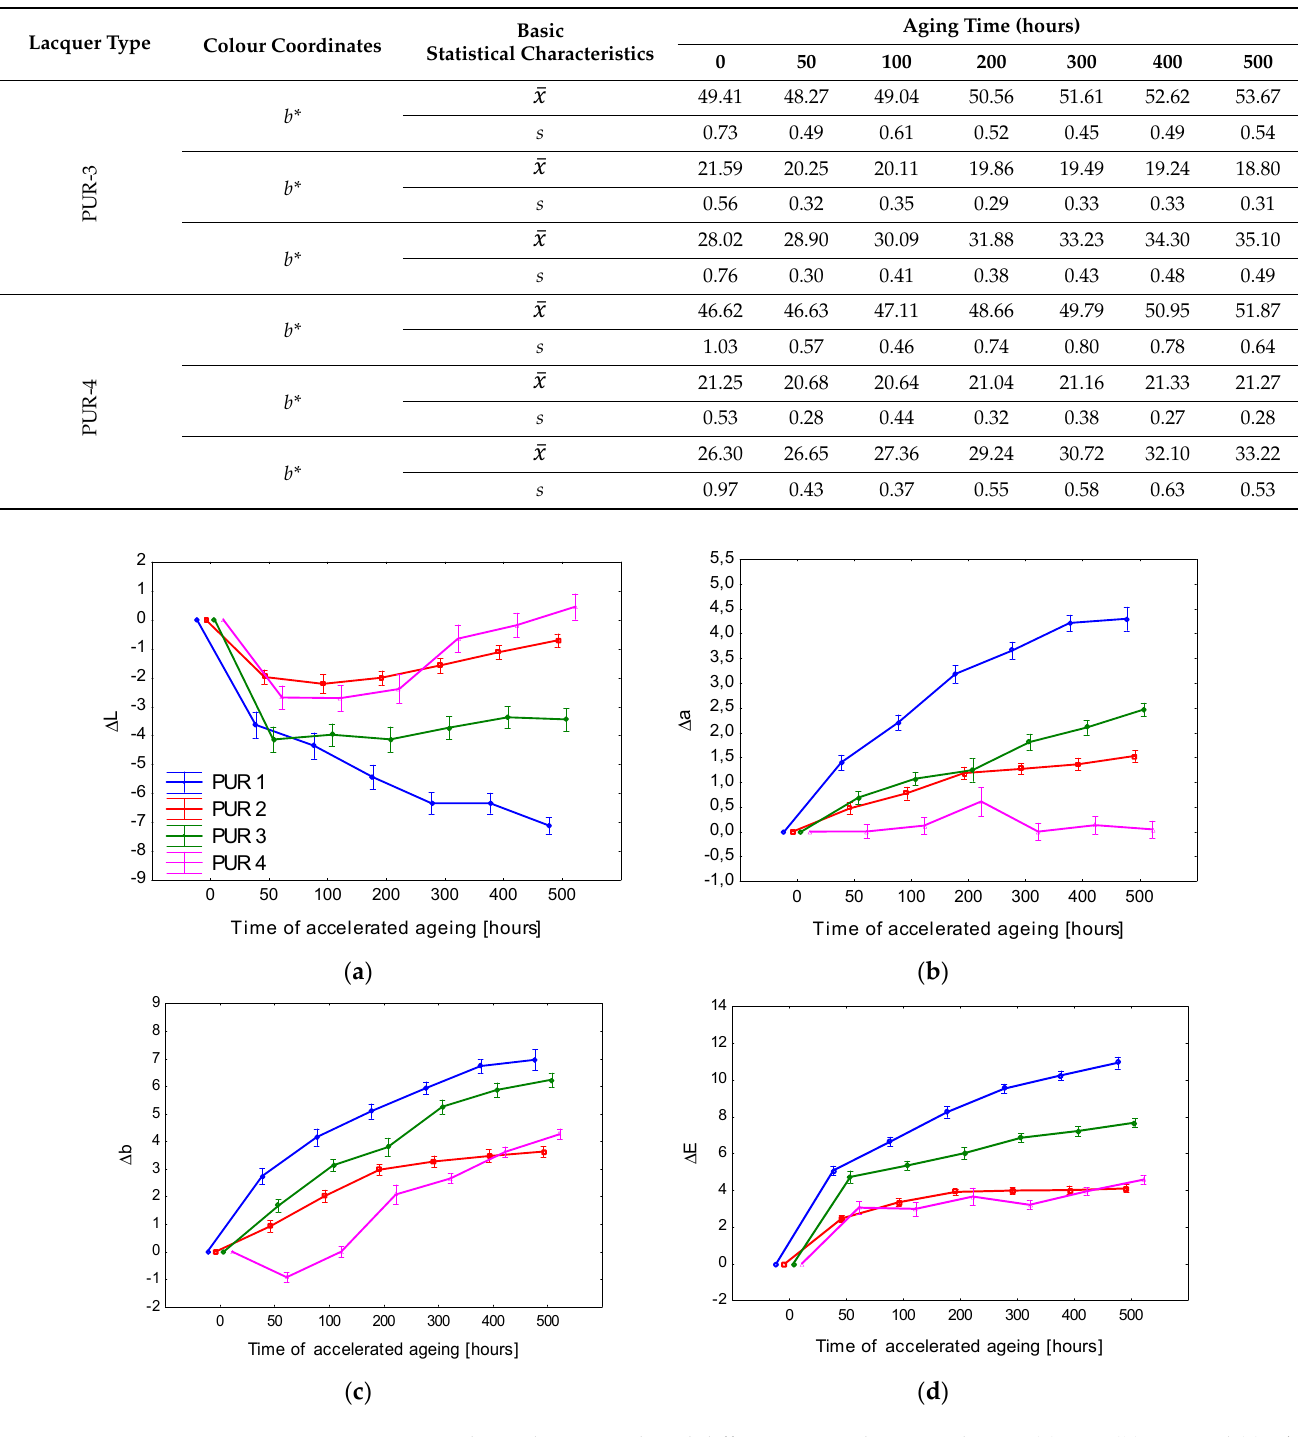
Figure 4. Accelerated-aging-induced differences in colour coordinates ( a ) Δ L* , ( b ) Δ a* , and ( c ) Δ b* , and the total colour difference ( d ) Δ E* of oak wood surfaces finished with polyurethane lacquers on surfaces without pigment mordants.